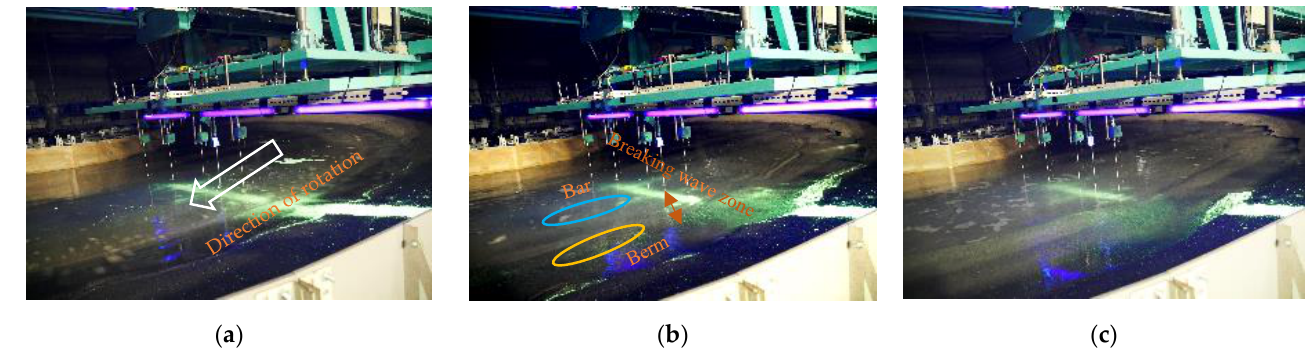
Figure 10. Snapshots of fluorescent sands movement during the experiment in Case 2: ( a ) after 1 min ( b ) after 20 min ( c ) after 60 min.